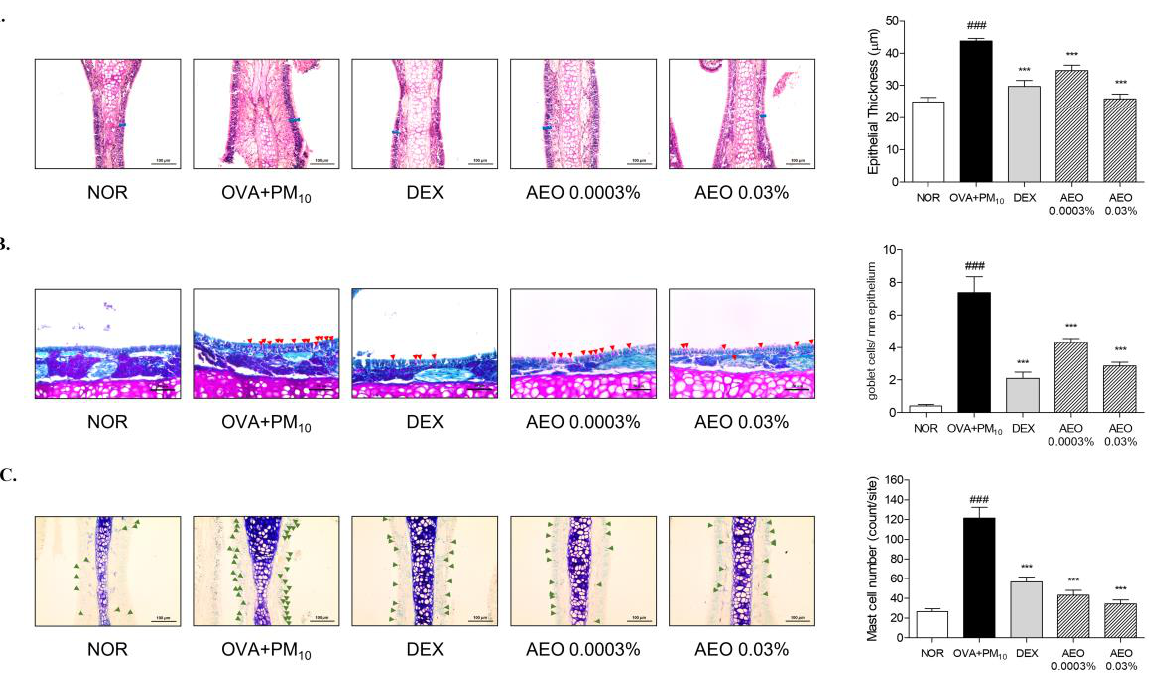
Figure 2. AEO ameliorated histological features presented in allergic rhinitis-like nasal epithelium of OVA+PM 10 -induced allergic rhinitis mice. Nasal epithelial tissues were stained with H&E. Blue bars indicate the nasal epithelial thickness (magnification × 200) ( A ). Goblet cells were stained with PAS indicated as a red arrowhead(magnification × 400) ( B ). Mast cells were stained with toluidine blue, indicated as a green arrowhead (magnification × 200) ( C ). The data are presented as the means ± standard error of the mean. ### p < 0.001 compared to the NOR group. *** p < 0.001 compared to OVA+PM 10 group.